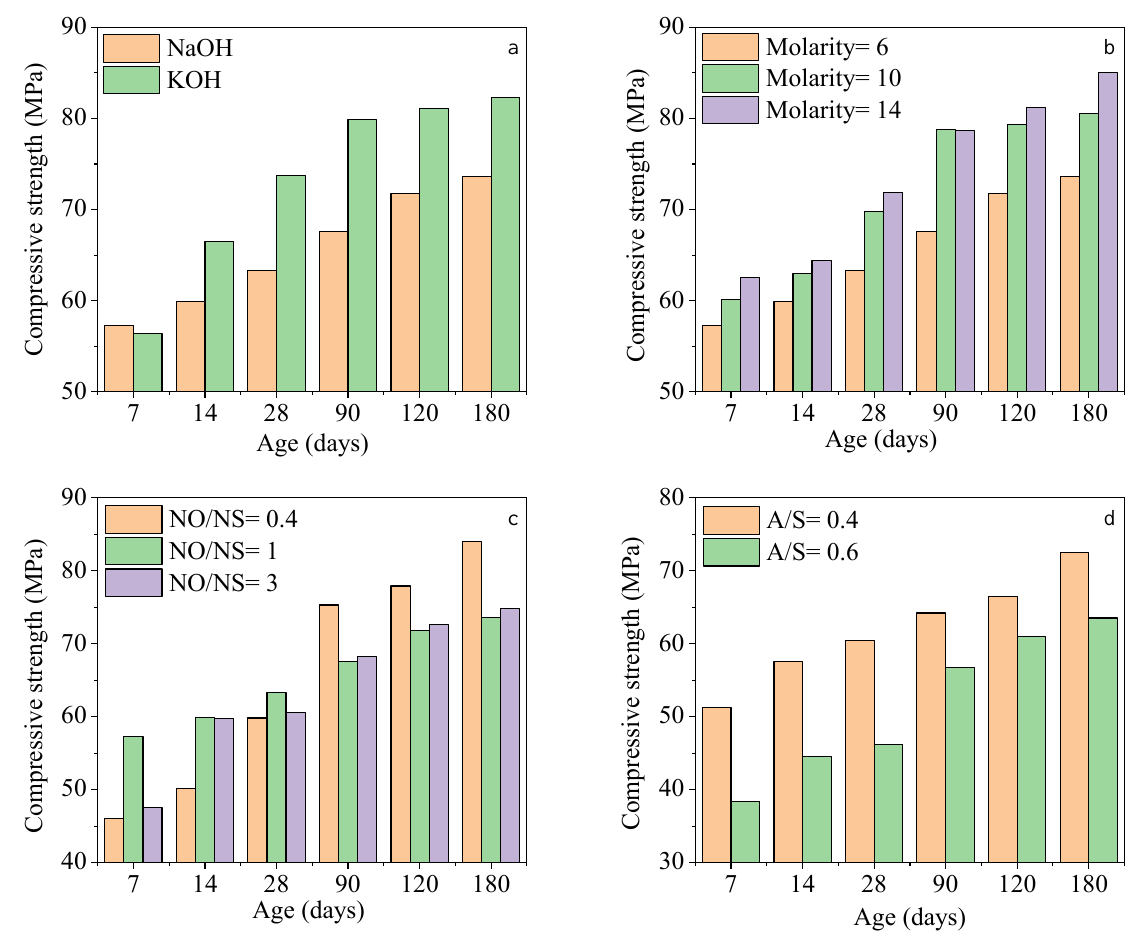
Figure 2. The effects of mix design parameters on compressive strength: ( a ) solution type (molarity = 6, A/S = 0.4, NO/NS = 1), ( b ) molarity (Solution = NaOH, A/S = 0.4, NO/NS = 1), ( c ) NO/NS ratio (Solution = NaOH, molarity = 6, A/S = 0.4), and ( d ) A/S ratio (Solution = NaOH, molarity = 10, NO/NS = 3).